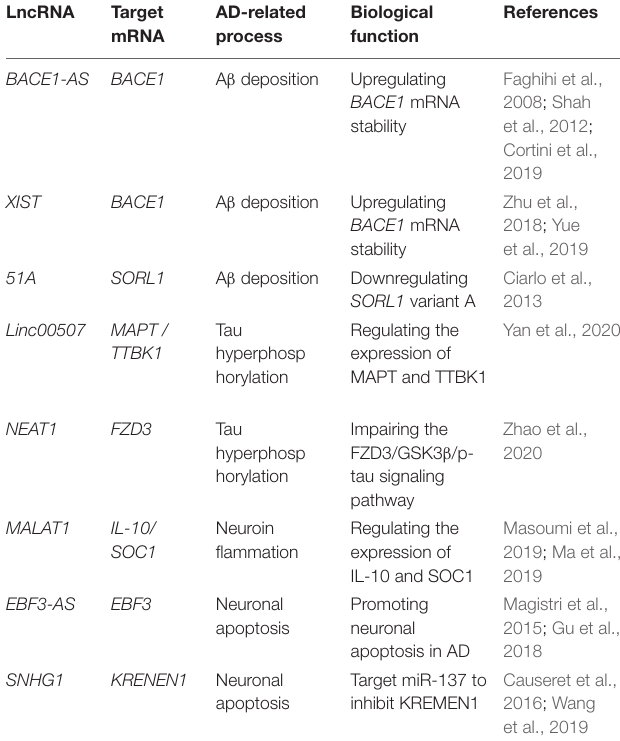
TABLE 1 | Main dysregulated long non-coding RNAs in Alzheimer’s